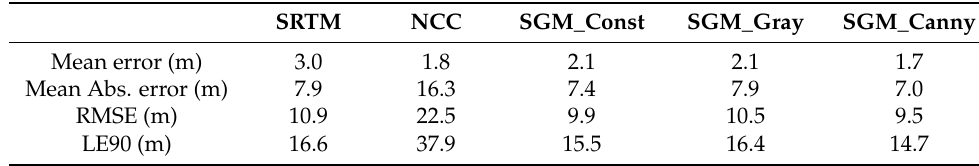
Table 5. Height accuracy of the test area 1 in blue